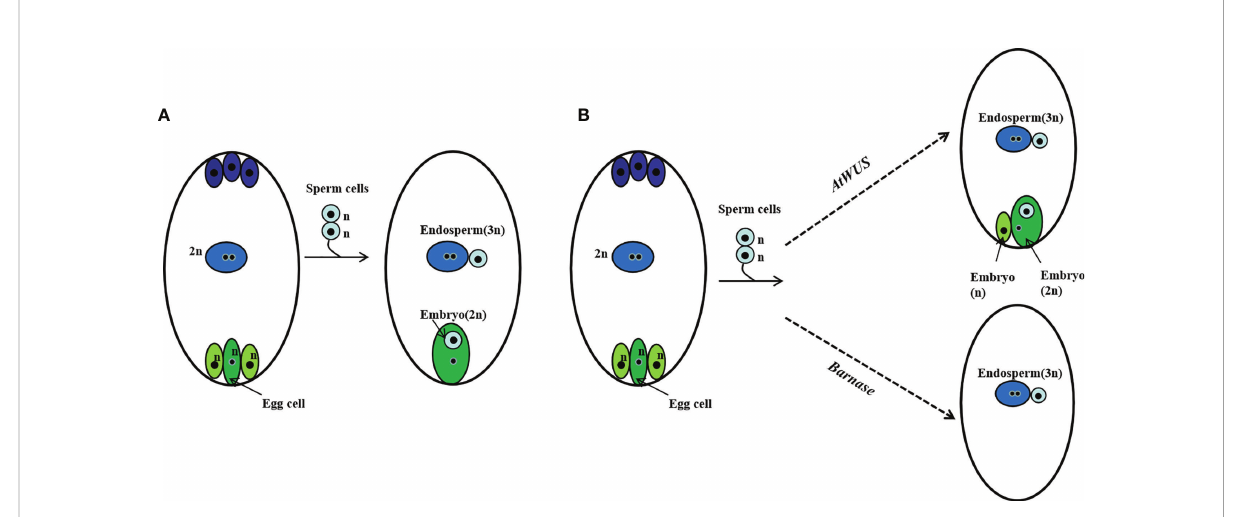
FIGURE 6 Schematic representation of polyembryony and embryo-free seed production. (A) Normal sexual reproduction and gamete fusion give rise to diploid progeny and triploid endosperm. (B) Ectopic expression of AtWUS induces other cells in the embryo sac to form embryos, the endosperm forms by fertilization of the central cell by a sperm cell. Asexual and sexual embryos share the endosperm formed during polyembryony. Ectopic expression of Barnase in the egg cell induces pollen single fertilization resulting in an embryo-free